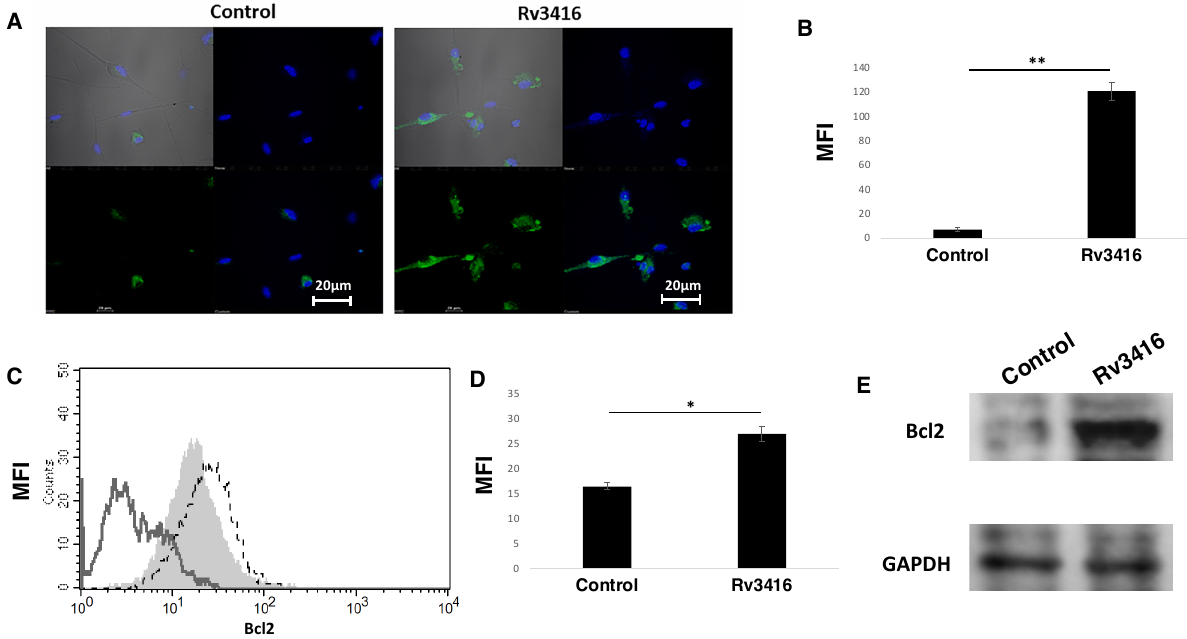
Figure 1: Rv3416 stimulation of BMDCs induces higher expression of Bcl2. For Panel A BMDCs were stimulated with 15 μg/ml Rv3416 for 24h. Cells were stained with biotinylated and streptavidin FITC conjugated specific antibody to Bcl2. Confocal imaging was performed with Nikon C2 laser scan confocal microscope. Nucleus was stained with DAPI (blue). Data were analyzed using the NIS Elements Advanced Research software. Bar chart in Panel B represents the mean Fluorescence Intensity of 5 fields. P value between groups Control and Rv3416 is P<0.01. Panel C represents flow cytometric analysis of Bcl2 protein expression in BMDCs as determined by immunostaining with Streptavidin FITC labelled Bcl2 mAb upon stimulation with Rv3416 for 24h. Thick grey line represents Isotype matched Control. Shaded histogram represents unstimulated cells and thin dotted line depicts cells stimulated with Rv3416 antigen. Data shows a representative image for two independent experiments. Panel D represents Mean Fluorescent Intensities of two independent experiments on the selected groups of Panel C. P value between groups Control and Rv3416 is P<0.05. Panel E represents a representative image of immunoblot for Bcl2 in BMDCs cytoplasmic extracts at 24h following stimulation with Rv3416. Student’s t-test was performed, * denotes statistical significance at P< 0.05. ** denotes statistical significance at P